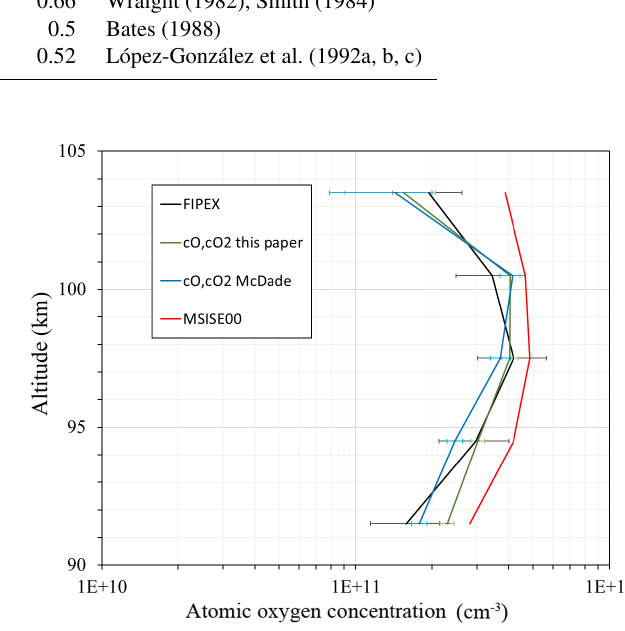
Figure 4. Atomic oxygen concentration: FIPEX (black line); model MSIS00 (red line); derived from emission observation with Mc- Dade et al. (1986) coefficients (blue line); calculated with newly derived fitting coefficients for the two-step mechanism (green